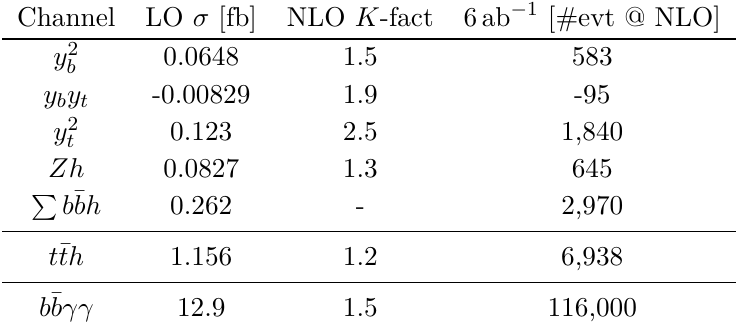
Table 1 . SM cross-section for the main background processes at 14 TeV with 6 ab − 1 data at the HL-LHC, and the number of events after the basic cuts as defined in eq. (3.2). For b ¯ bh production, the Higgs boson is decayed to a pair of photons. The total production cross-section of Higgs associated with a b ¯ b pair is denoted by P b ¯ bh and is the sum of the top four channels.